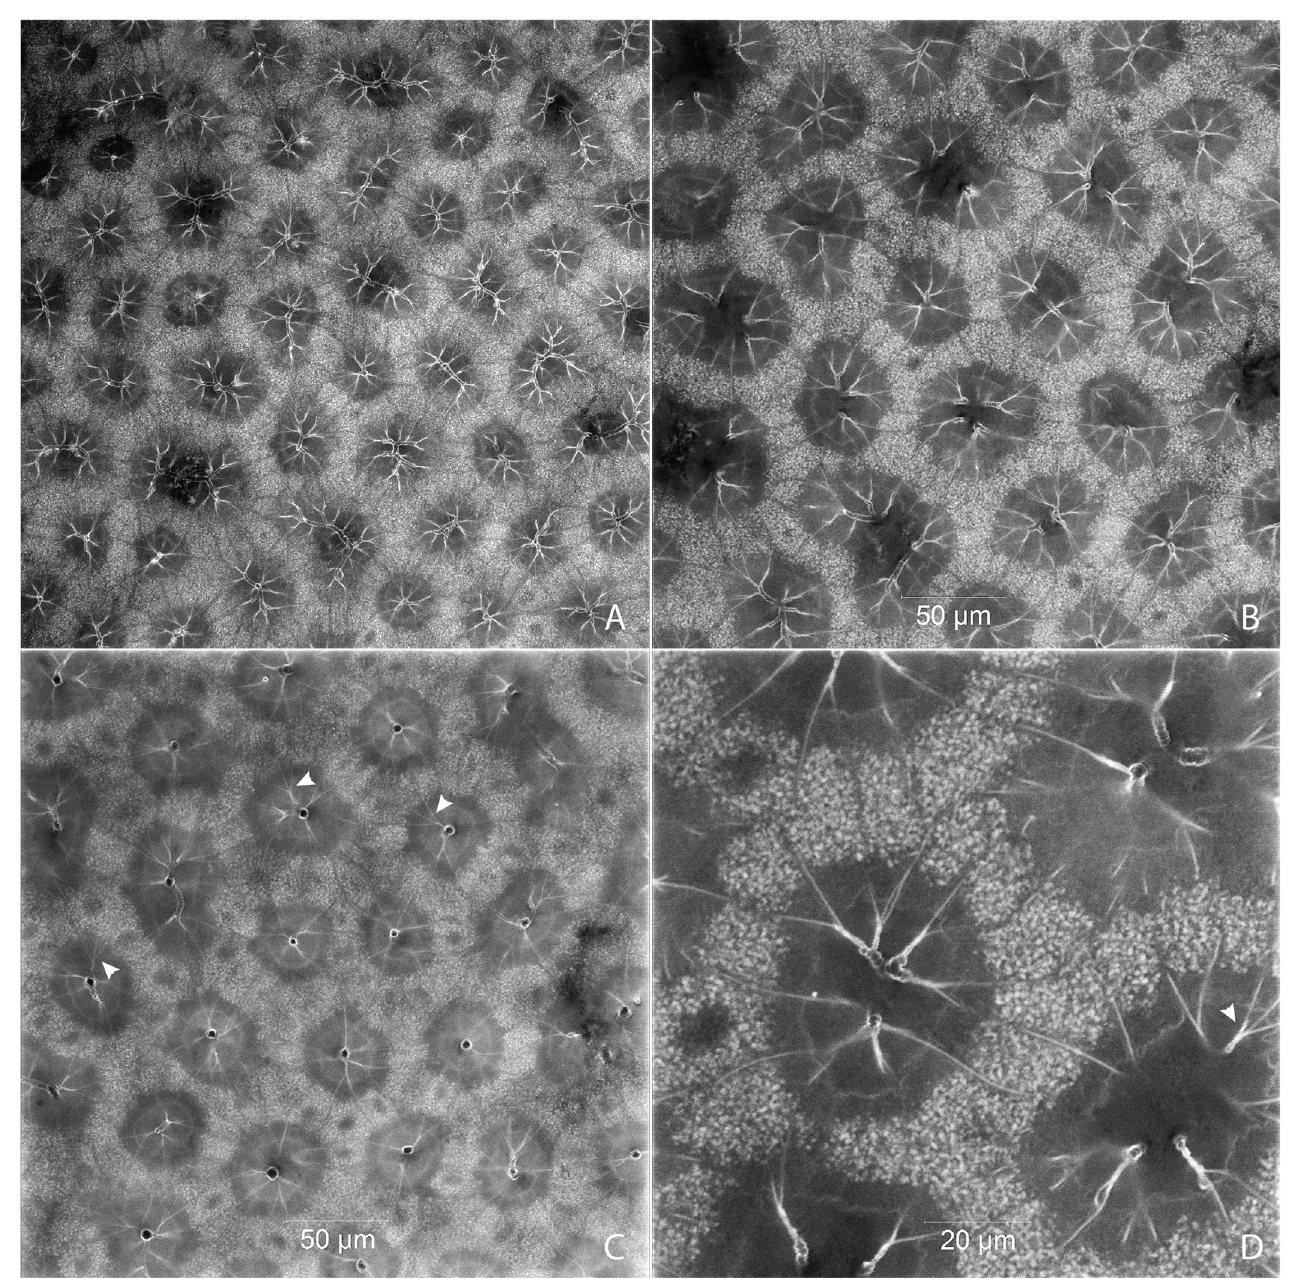
Fig 31. Tracheae and tracheoles in each tracheal end organ cylinder comprising the adult male tracheal brush in Photinus pyralis . Preparation was cleared using lactic acid. Arrowheads pointing to junctions where tracheal twigs branch into three tracheoles. A, B, and C show terminal tracheae near the ventral surface of the photogenic layer; C shows an optical section further from the ventral